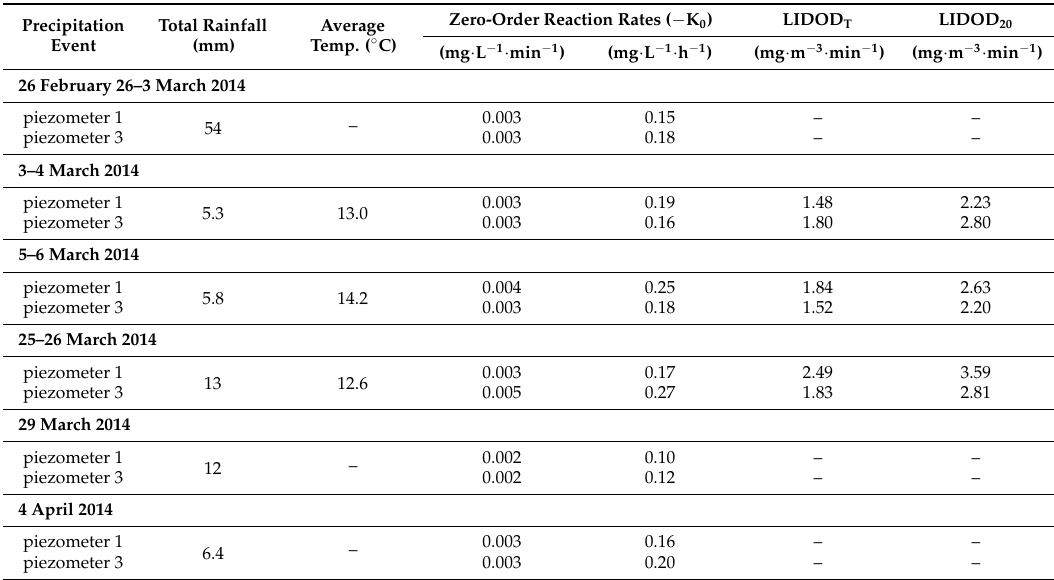
Table 2. Zero-order rates of oxygen reduction, LIDODT, and LIDOD20 for piezometers 1 and 3 during precipitation events February to April